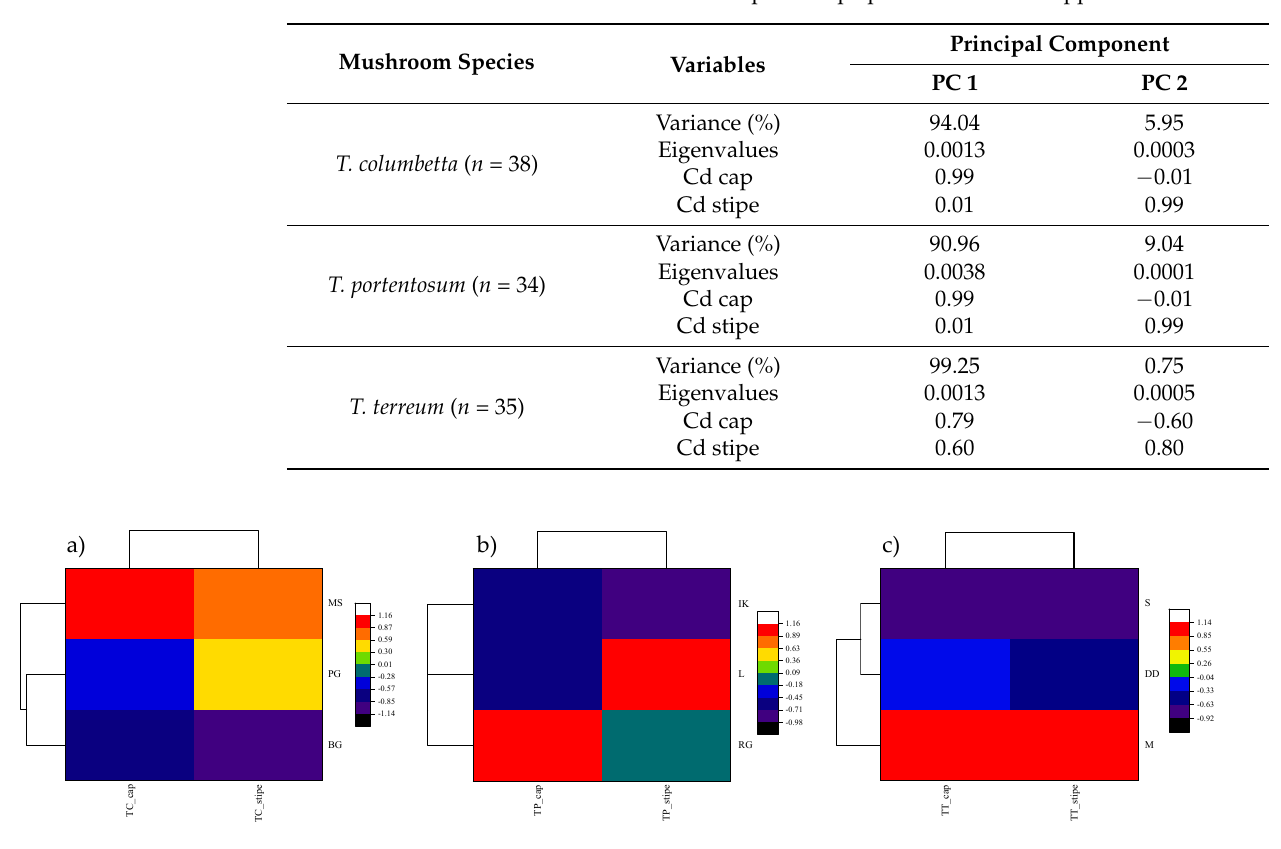
Table 4. Daily intakes of Cd and health risk index in wild edible Tricholoma spp. mushrooms.